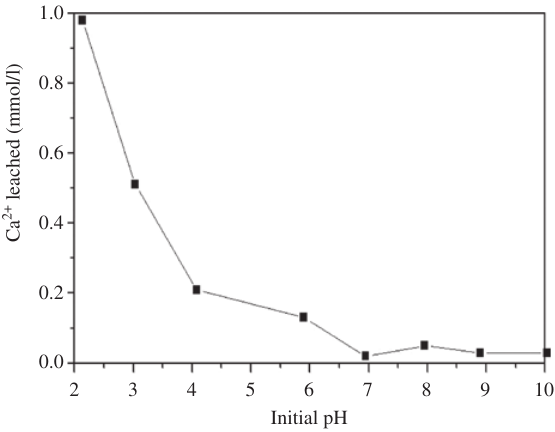
Table 3: Initial pH (pH containing 0.1 g HAp.